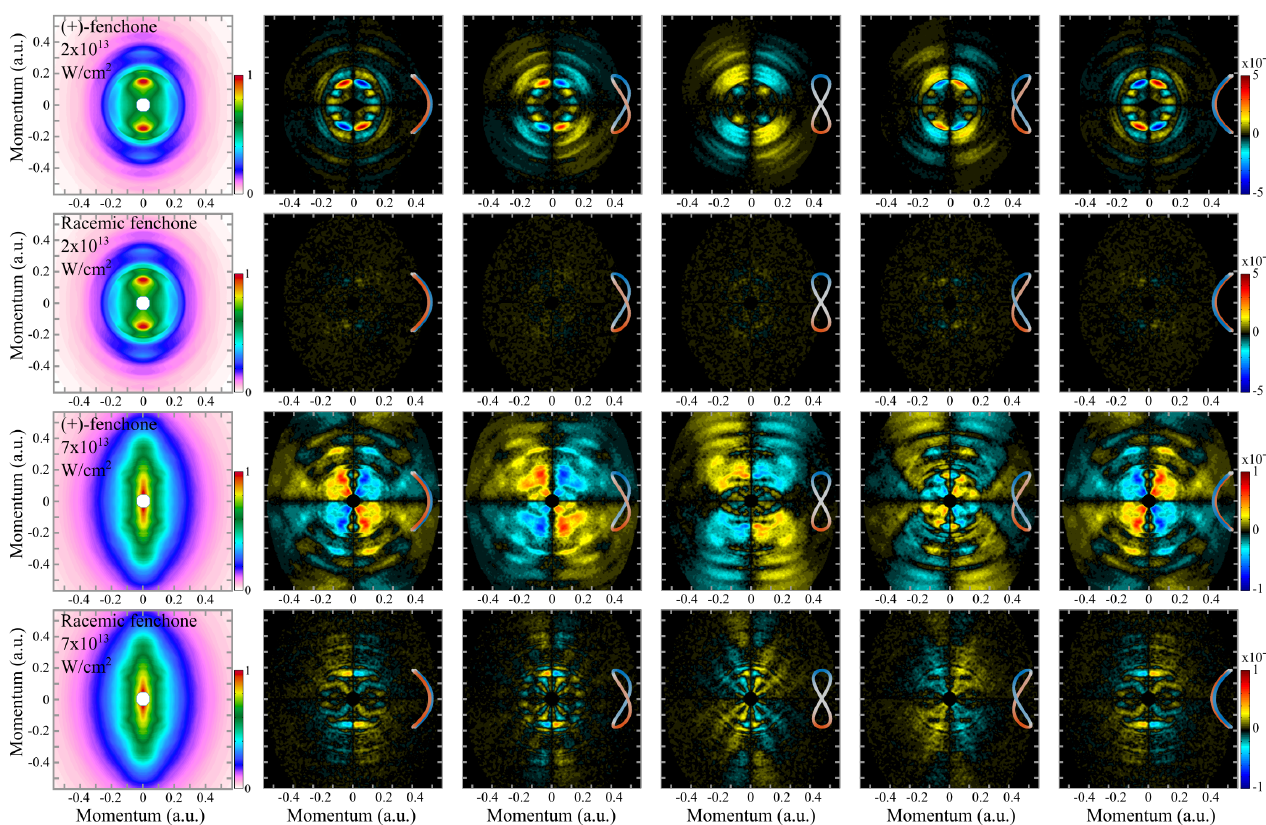
FIG. 12. Comparison of the ESCARGOT signal obtained in ( þ )-fenchone (first and third rows) and a racemic mixture (second and fourth rows), at 2 × 10 13 and 7 × 10 13 W cm − 2